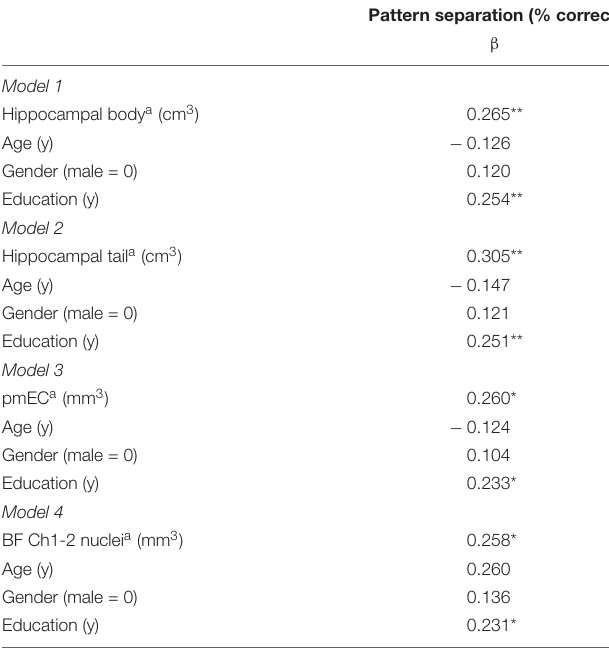
TABLE 4 | Regression analyses of spatial pattern separation performance and volumes of specific hippocampal and entorhinal cortex subregions and basal forebrain Ch1-2 nuclei controlled for demographic